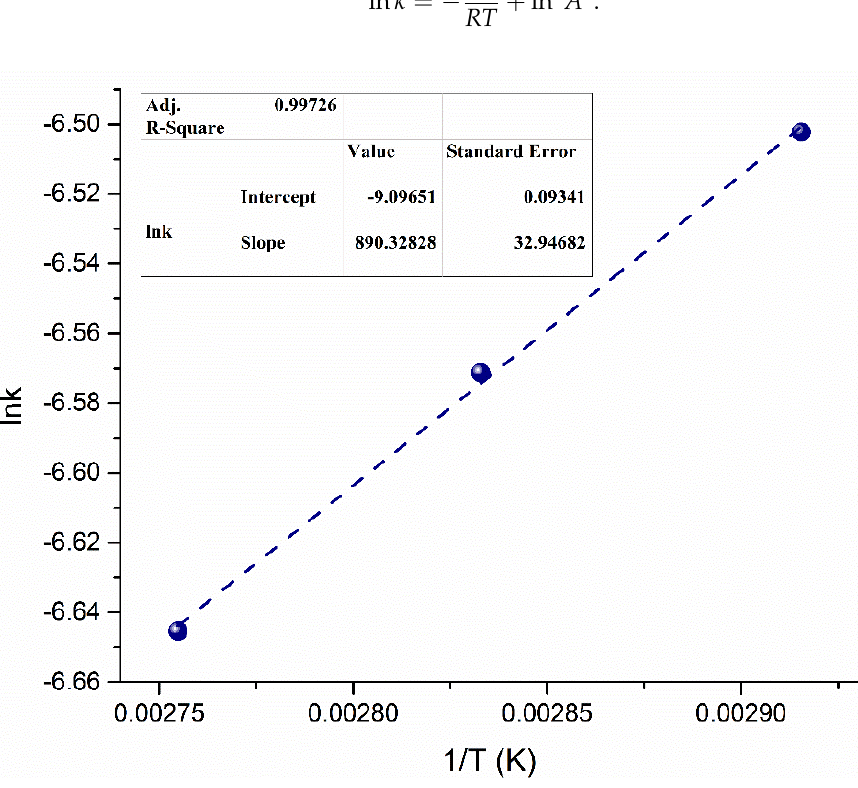
Figure 8. Arrhenius plot for determining E A required to convert WCO into biodiesel. The E A of the 7% Sr/ZrO 2 -based biodiesel production process using microbubble technology was estimated as 7.4 kJ · mol − 1 . The achieved E A is lower than that of other biodiesel processes with different catalysts (Table 4). The low E A also implies that 7% Sr/ZrO 2 in the system facilitated the vapor – liquid system and enhanced the overall reaction rate. Fur- thermore, the low E A indicates that less energy was needed for the reactant to pass the